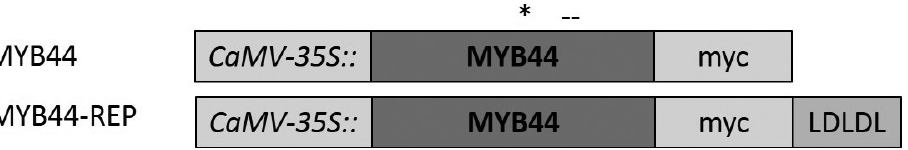
Figure 2. Schematic illustration of DNA constructs used for overexpression in planta . Relative positions of MPK3 phosphorylation site (*) and the putative endogenous EAR motif (--) are indicated.